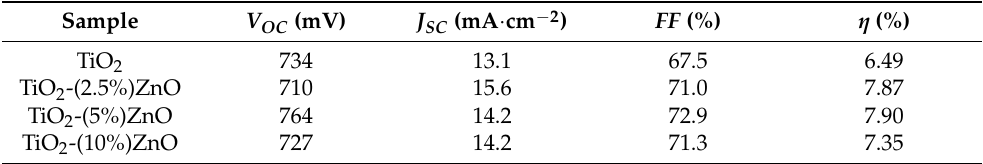
Table 6. The photovoltaic parameters of DSSCs utilizing TiO 2 -ZnO photoanodes. Sample